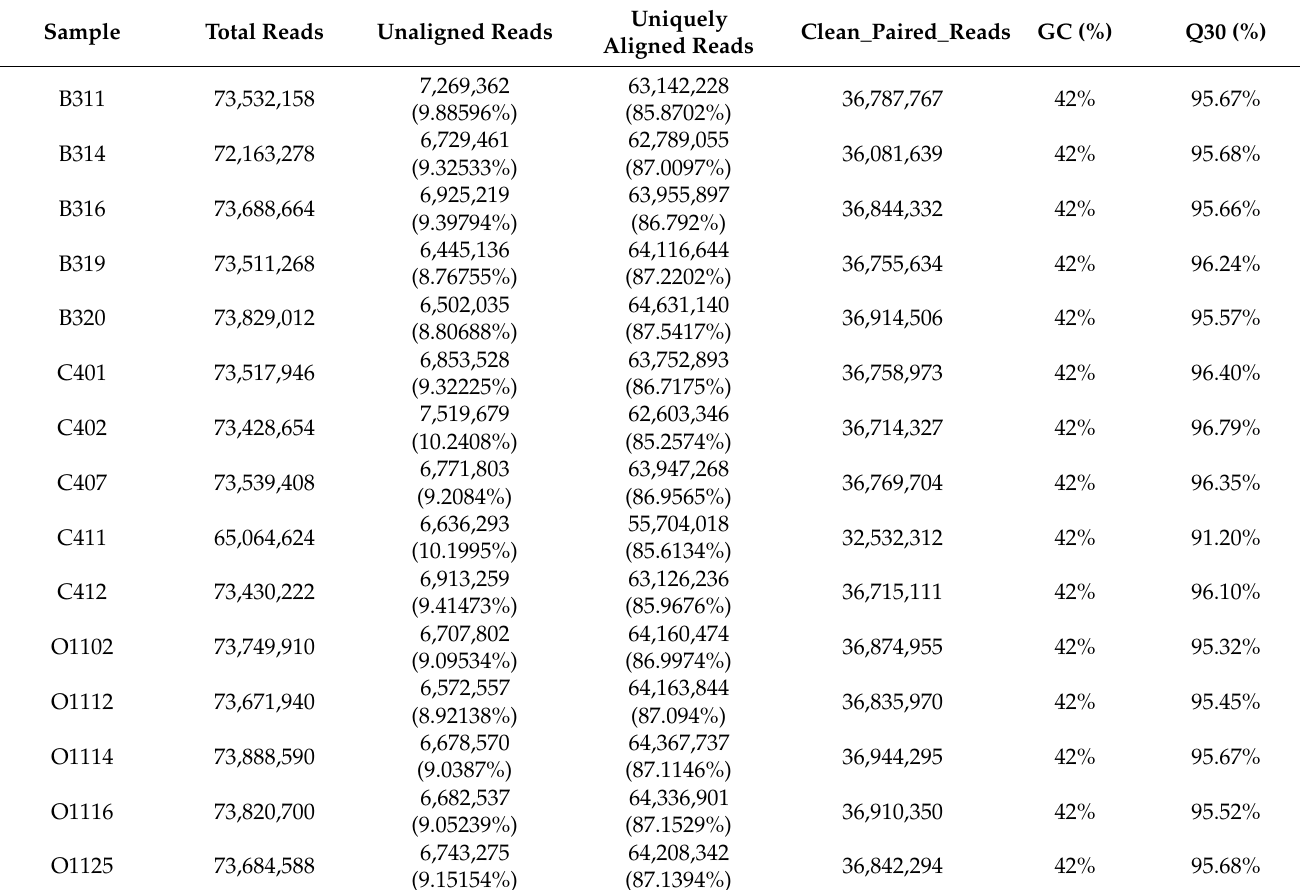
Table 2. Sequencing data